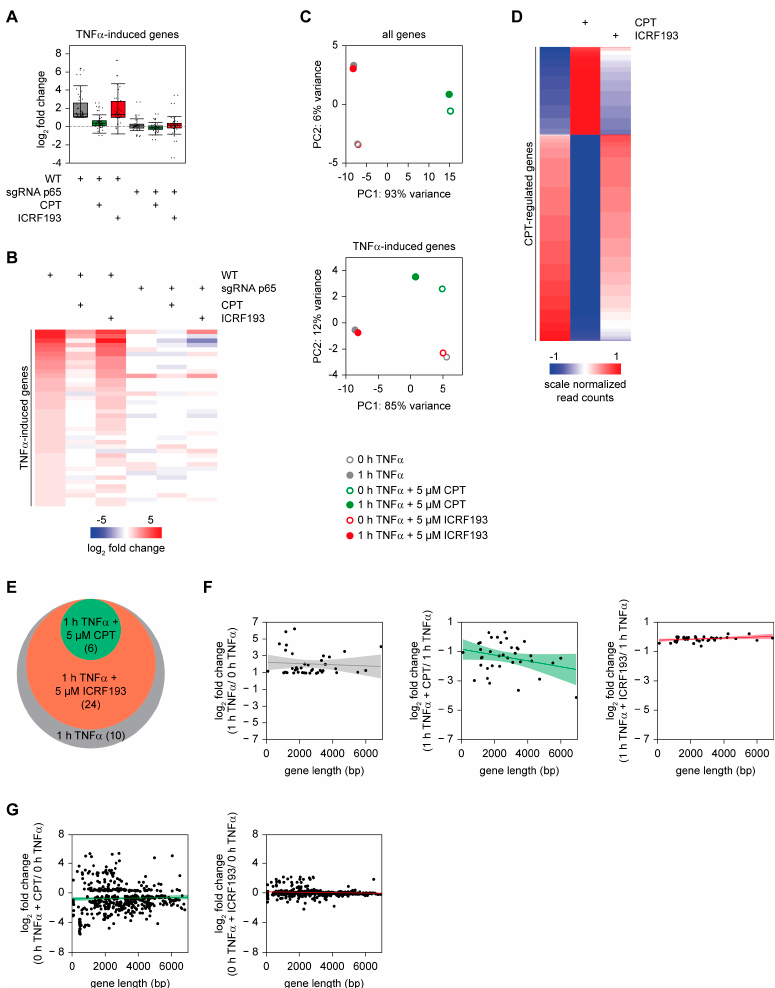
Figure 2. RNA-seq analysis of CPT e ff ects on TNF α -triggered gene expression in HCT116 WT and p65-deficient HCT116 cells. ( A ) HCT116 and p65-deficient HCT116 cells were pre-treated for 2 h with CPT or ICRF193 (5 µ M each), followed by stimulation for 1 h with TNF α (20 ng / mL). RNA-seq analysis results are depicted in a boxplot, each dot represents a regulated gene measured by ≥ 20 reads in at least one condition and undergoing an upregulation of > 1 log2 fold change (LFC) upon TNF α -stimulation. The boxed area displays the region containing the second and third quartile, the median is indicated. ( B ) Heat map visualization of the RNA-seq experiment, only genes with a LFC > 1 and ≥ 20 reads in at least one condition are displayed (40 genes). ( C ) The upper part shows a two-dimensional PCA analysis of the RNA-Seq data for the indicated conditions in HCT116 WT cells. The lower part shows a PCA analysis for the 40 genes that are upregulated > 2-fold in response to TNF α treatment. ( D ) Heat map visualization of CPT and ICRF193 e ff ects on basal gene expression of HCT116 WT cells. As these TOP1 inhibitors can potentially a ff ect housekeeping genes used for normalization, read counts are displayed. Gene counts are normalized by DESeq2 and filtered for significant ( p value < 0.05) expressed CPT regulated genes (0 h TNF α + CPT versus 0 h TNF α (500 genes)). ( E ) Venn diagram visualizing the distribution of genes undergoing a > 2-fold induction of TNF α -triggered gene expression in the absence or presence of the indicated inhibitors. ( F ) Correlation of the TNF α -induced changes in gene expression (in log2 scale) in the absence (left) or presence of inhibitors for TOP1 (middle) and TOP2 (right) versus the gene length. Only genes with a LFC > 1 and ≥ 20 reads in at least one condition are displayed. The colored central line represents the linear smooth, the colored area displays the confidence interval around the smooth. ( G ) HCT116 WT cells were treated for 2 h with CPT or ICRF193 (5 µ M each). Genes showing a LFC > 1 upregulation or downregulation and showing a p -value < 0.05 were not correlated with gene